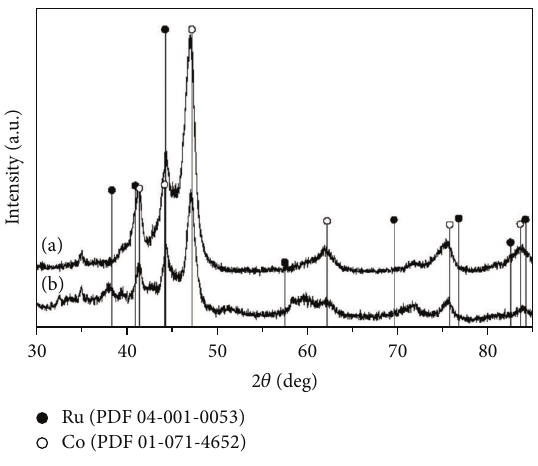
Figure 3: XRD patterns of species fabricated by hydrothermal route (120 ∘ C, 10h) in the solutions containing 40mmol/L CoCl 2 80mmol/L sodium citrate, 0.33 mol/L NaOH, 108 mL/L hydrazine hydrate (50%), and RuCl 3 (mmol/L): (a) 2.5; (b) 5.0.